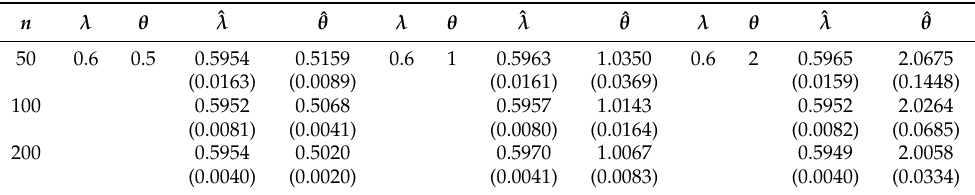
Table 1. Empirical means and MSEs of the maximum-likelihood estimates of the LiE1 for different values of the